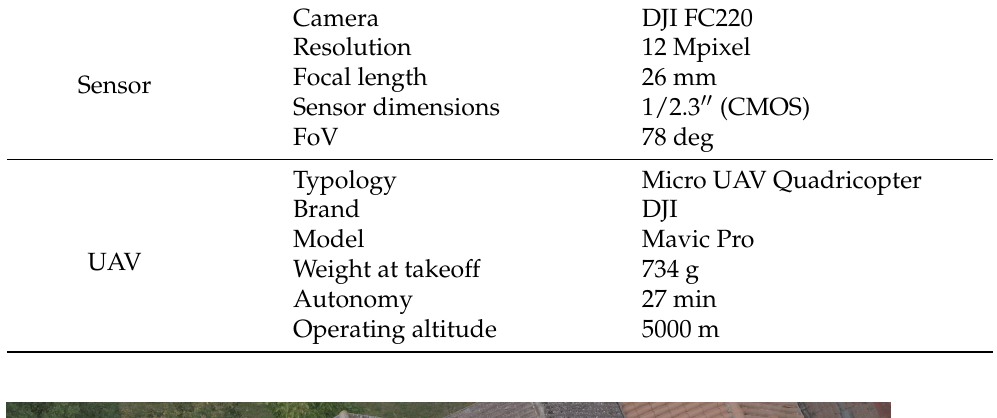
Table 1. Technical specification of the instrumentation used for the UAV photogrammetry surveys in Genzano.